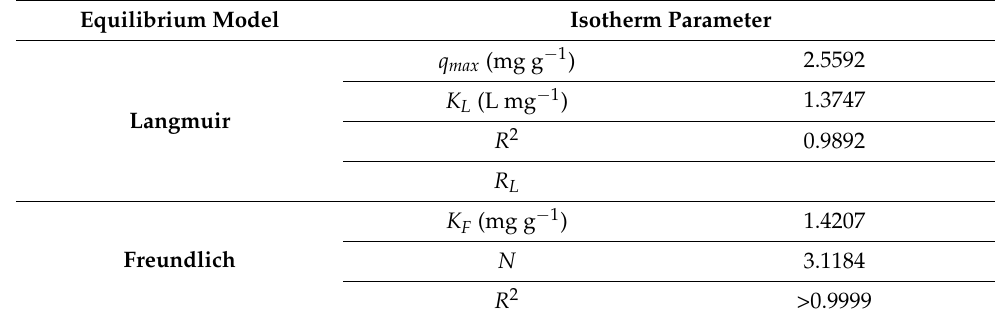
Table 3. Isotherm model parameters for CPX biosorption by